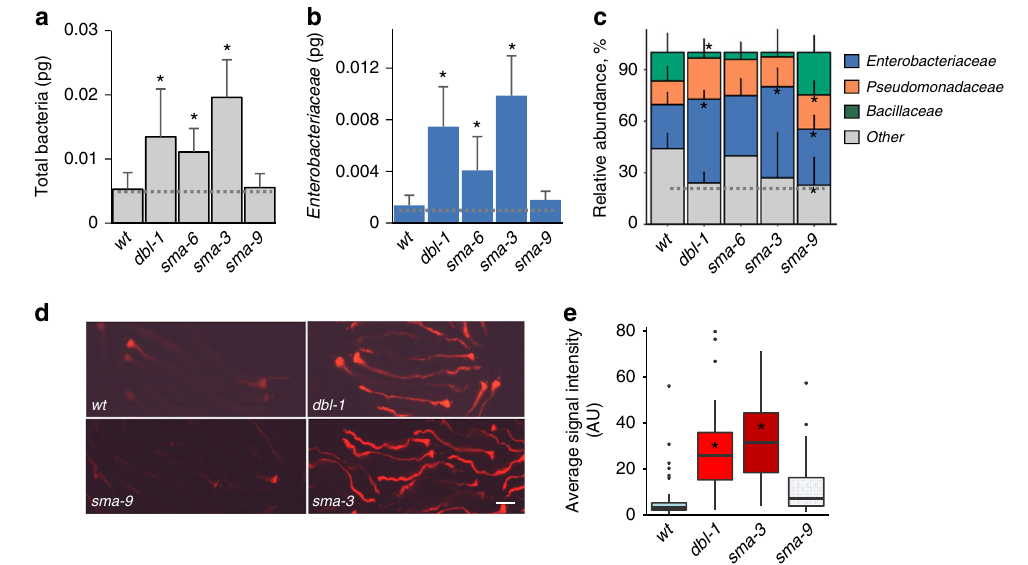
Fig. 4 Disruption of TGF β /BMP signaling alters gut microbiota size and composition independent of effects on body size. a , b Bacterial load in wild- type worms and TGF β mutants — dbl-1(nk3), sma-6(wk7), sma-3(e491) , and sma-9(wk55) , raised on the SC1 community, showing abundance of all Eubacteria ( a ), or Enterobacteriaceae ( b ). Average± SD of two independent experiments. Measurements were performed on a pool of n = 30 worms per experiment. c Relative abundance of all measured taxa (including also Pseudomonadaceae and Bacillaceae ), calculated based on the absolute quantities, as in Fig. 1; light gray bar represents relative abundance of all ‘ other ’ bacterial groups not directly measured. * p < 0.05 (analysis of variance (ANOVA)) compared with wild- type animals. d , e Representative images ( d ) and quanti fi cation ( e ) of colonization of TGF β /BMP mutants by tdTomato-expressing CEent1 . Box plots present medians (center line), fi rst and third quartiles (bottom and top of box, respectively), minimum and maximum values (whiskers), and outliers (dots, de fi ned as >1.5 times above/below the interquartile range). * p < 10E – 13 (generalized linear model) compared with wild-type animals; N ( wt) = 47, N ( dbl-1 ) = 42, N ( sma-3 ) = 66, N ( sma-9 ) = 89. Size bar, 0.1 mm